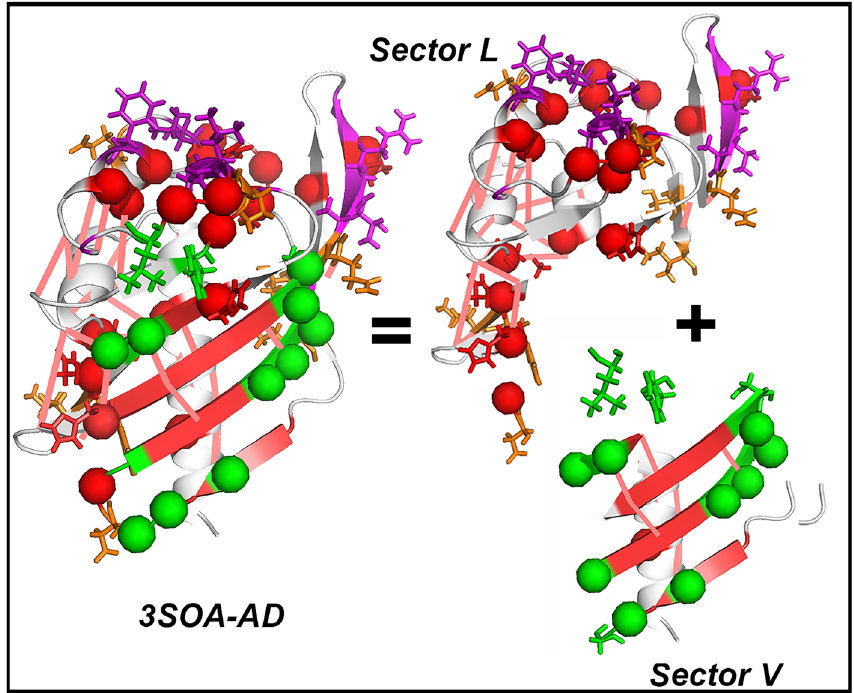
Figure 3. The two sectors of the CaMKIIα AD. The coevolved residue network of the primordial vertical dimer (Sector V) has energetically relaxed residues (green spheres) at the Vert-Dim contact interface (red β strands). The coevolved residue network (thick salmon lines) of the Lat-Dim contact (Sector L) has energetically stressed residues (red spheres) at the contact interface (purple α-helix, β strands). Stick representations denote residues at the interface (purple, green, red) or part of adjacent dynamic couplings (gold). 3D-view in Supplementary Video S8. Source listed in Table